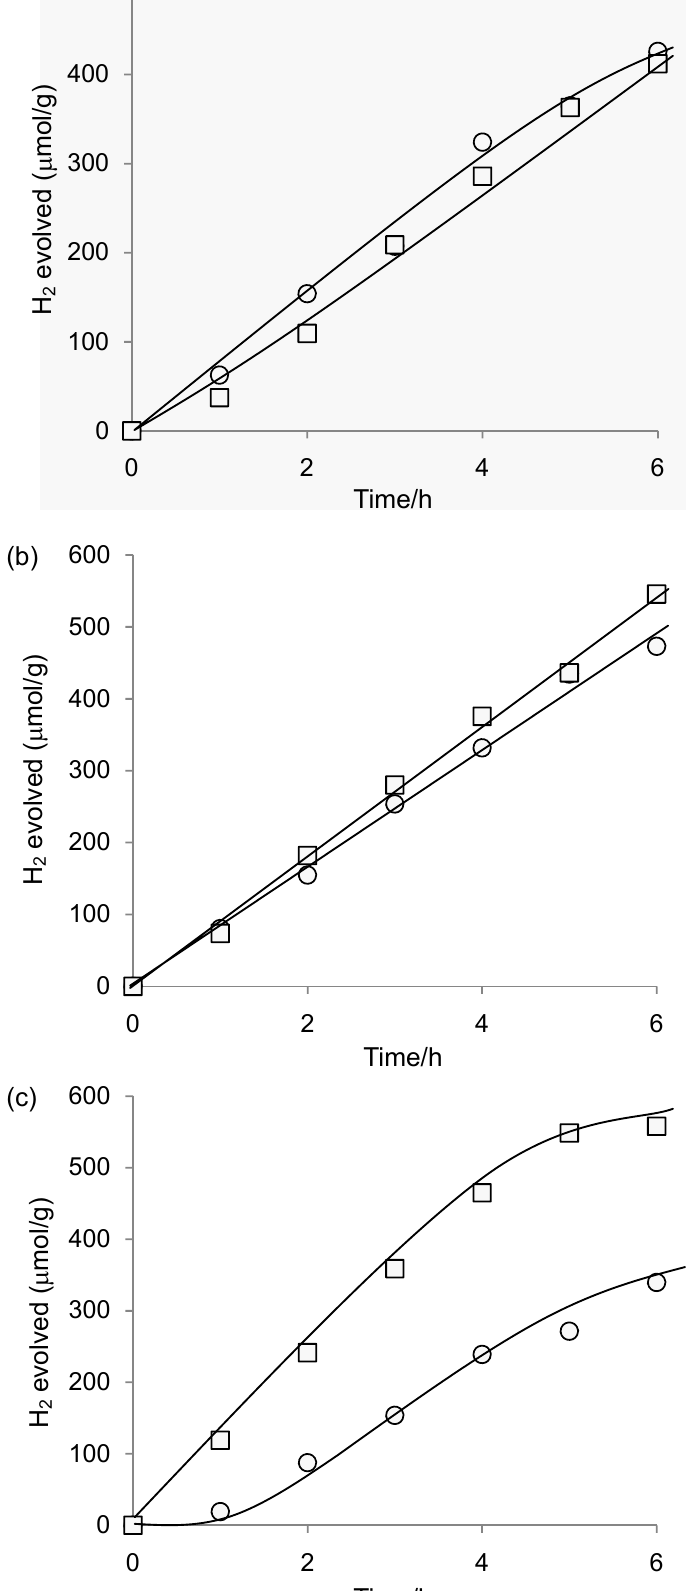
(1.6), (b) 1 -Pt-TiO (3.9), 2 2